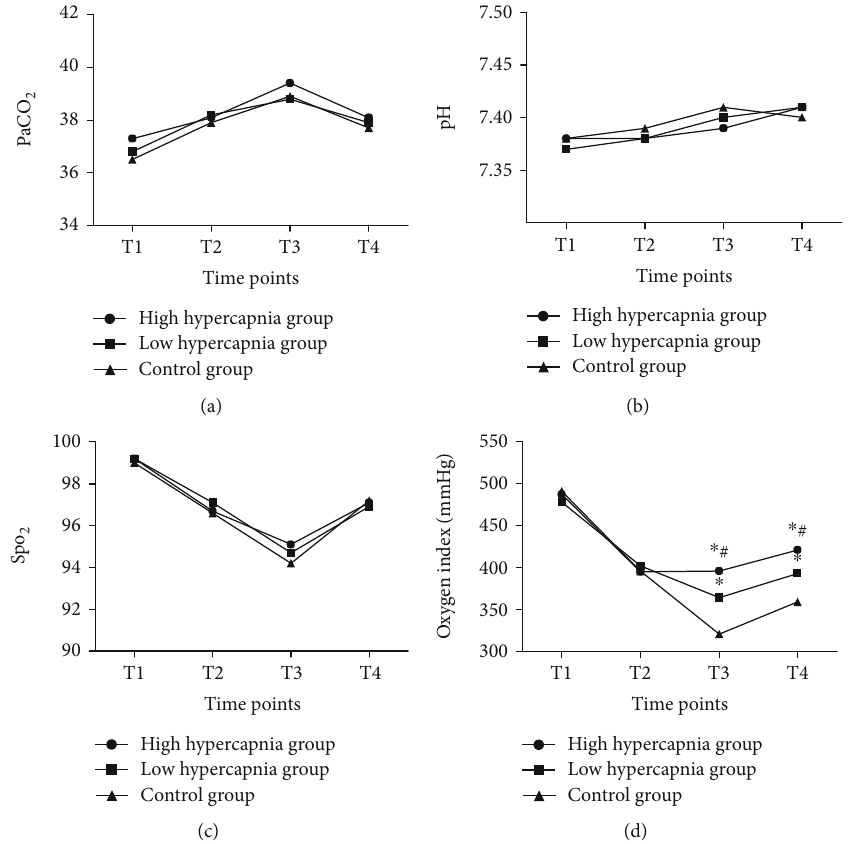
Figure 2: Analysis of arterial blood samples. The di ff erence in the levels of arterial blood PaCO each time point in the three groups; the ratio of arterial oxygen partial pressure to fractional inspired oxygen (PaO high hypercapnia group was signi fi cantly higher than that in the low hypercapnia group and control at T3 and T4 (d). T1: before operation; T2: 30 min after pneumoperitoneum; T3: 24 h postoperation; T4: 72 h postoperation. ∗ Compared with control group; # compared with low hypercapnia